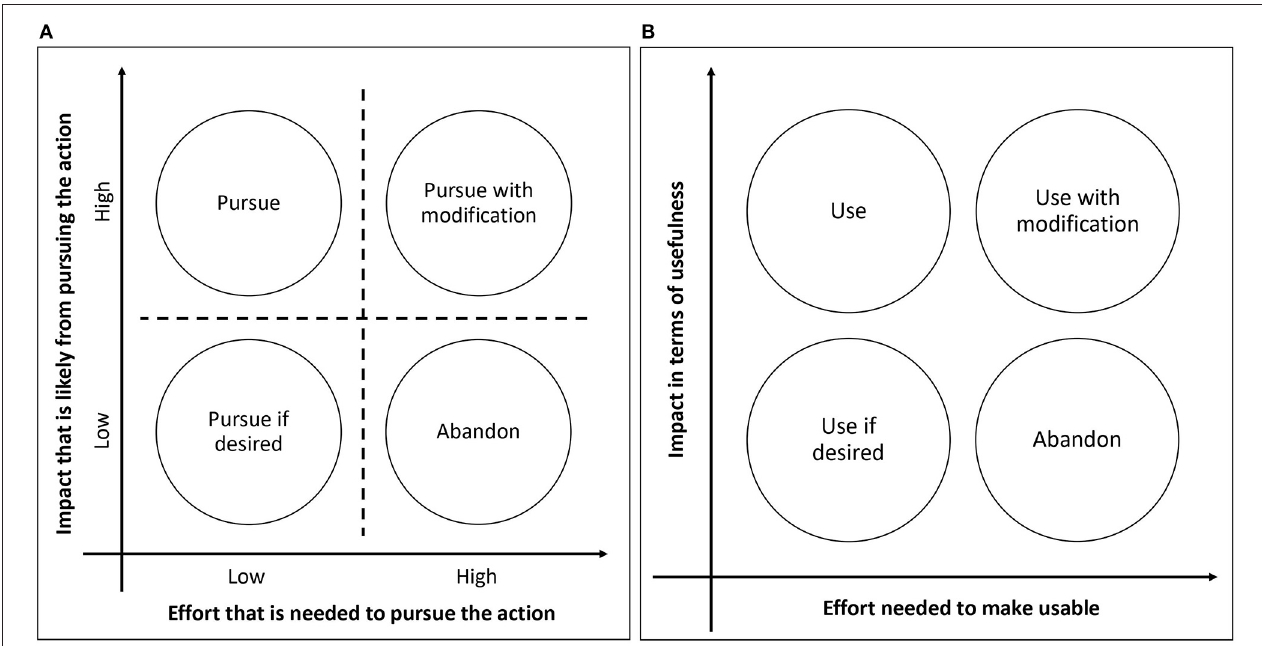
FIGURE 1 | (A) An effort-vs-impact chart. (B) An adapted effort-vs-impact chart for assessing whether/how to use a technological implementation